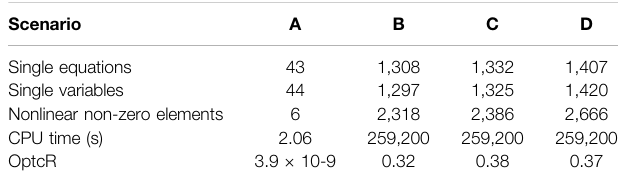
TABLE 7 | Model statistics.